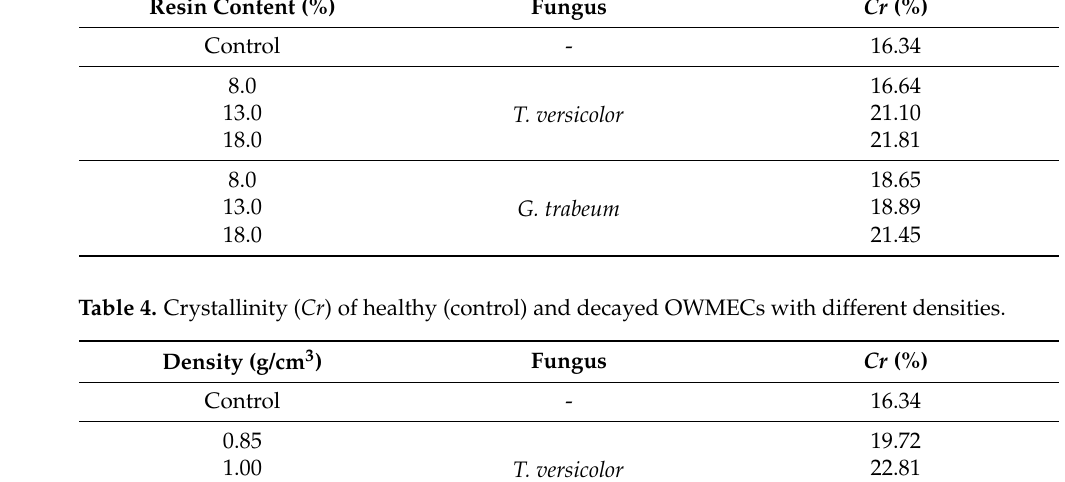
Figure 8. XRD patterns of healthy (control) and decayed OWMEC samples with different densities: ( a ) T. versicolor decay; ( b ) G. trabeum decay. Table 3. Crystallinity ( Cr ) of healthy (control) and decayed OWMECs with different resin contents. Resin Content (%) Fungus